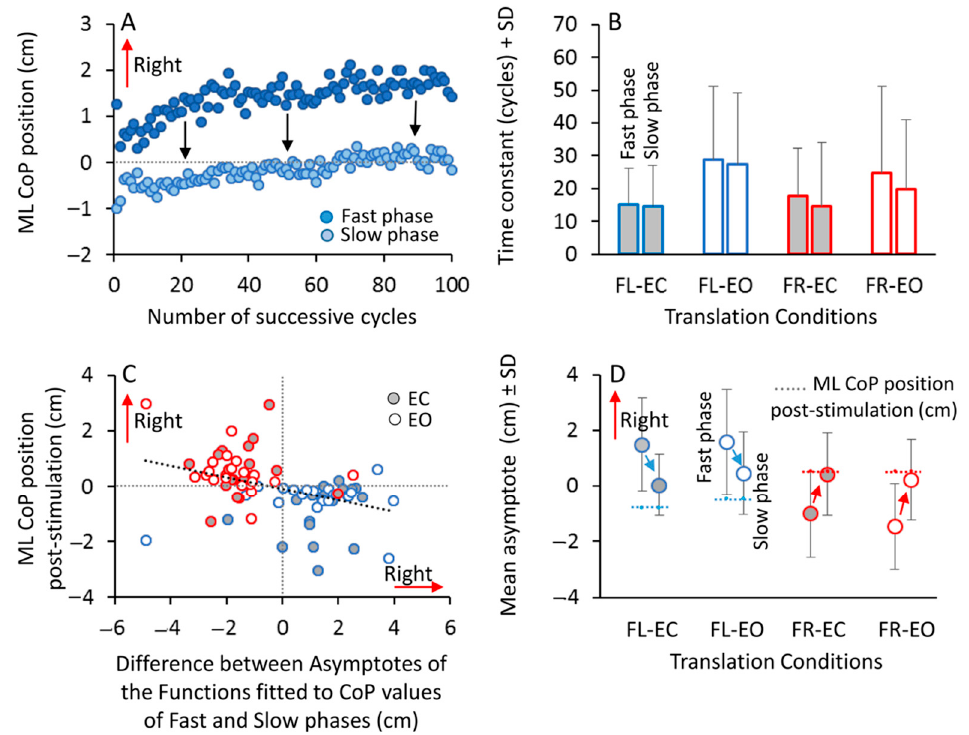
Figure 4. Mean ML CoP positions during the fast and slow phases of the stimulation cycles (FL–EC condition) and their asymptotic values obtained by the exponential fit (ensemble averaged group means). ( A ) During the fast phase to the left (dark blue circles), the mean ML CoP position shifted to the right side of the force platform. During the slow phase (light blue circles) it moved to the left (arrows) with respect to the position reached during the fast phase. In the last cycles, the ML CoP position during the slow phase was close to the pre-stimulation position. ( B ) Mean values of the time constant of the exponential function fitted to the ML CoP position during the fast and during the slow phases. The bars with the blue outline refer to FL, and the bars with the red outline to FR. Grey filling denotes EC, and white filling EO. ( C ) For each subject, the mean post-stimulation ML CoP position was plotted against the di ff erence in the asymptotic value of the ML CoP position between the fast and the slow phase for the FL-EC (grey filling with blue outlined circles), FL–EO (white filling with blue outline), FR–EC (grey filling with red outline) and FR–EO (white filling with red outline). ( D ) The mean values of the asymptotes of the fast and the slow phases were reported. Circles with blue outlines refer to FL and the circles with red outlines to FR condition. Grey filling refers to EC, and white filling to EO. The blue and red dotted lines are the mean ML post-stimulation CoP positions in the four conditions.